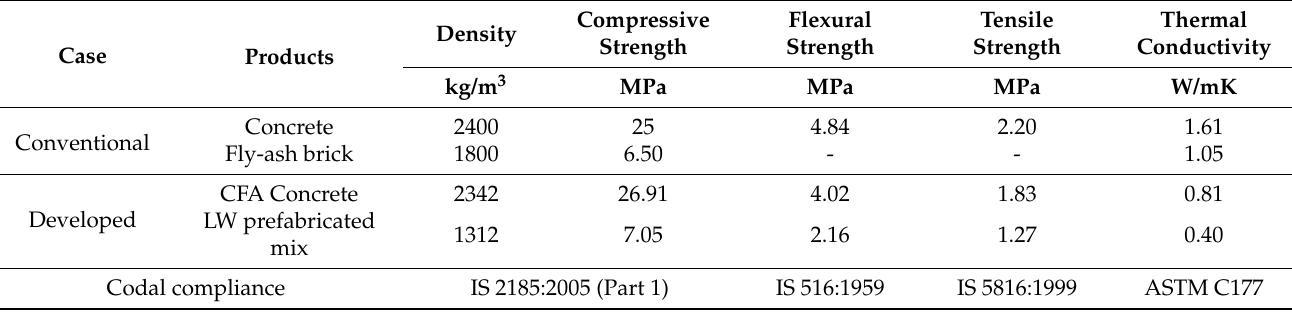
Table 3. Physico-mechanical and functional properties of materials.